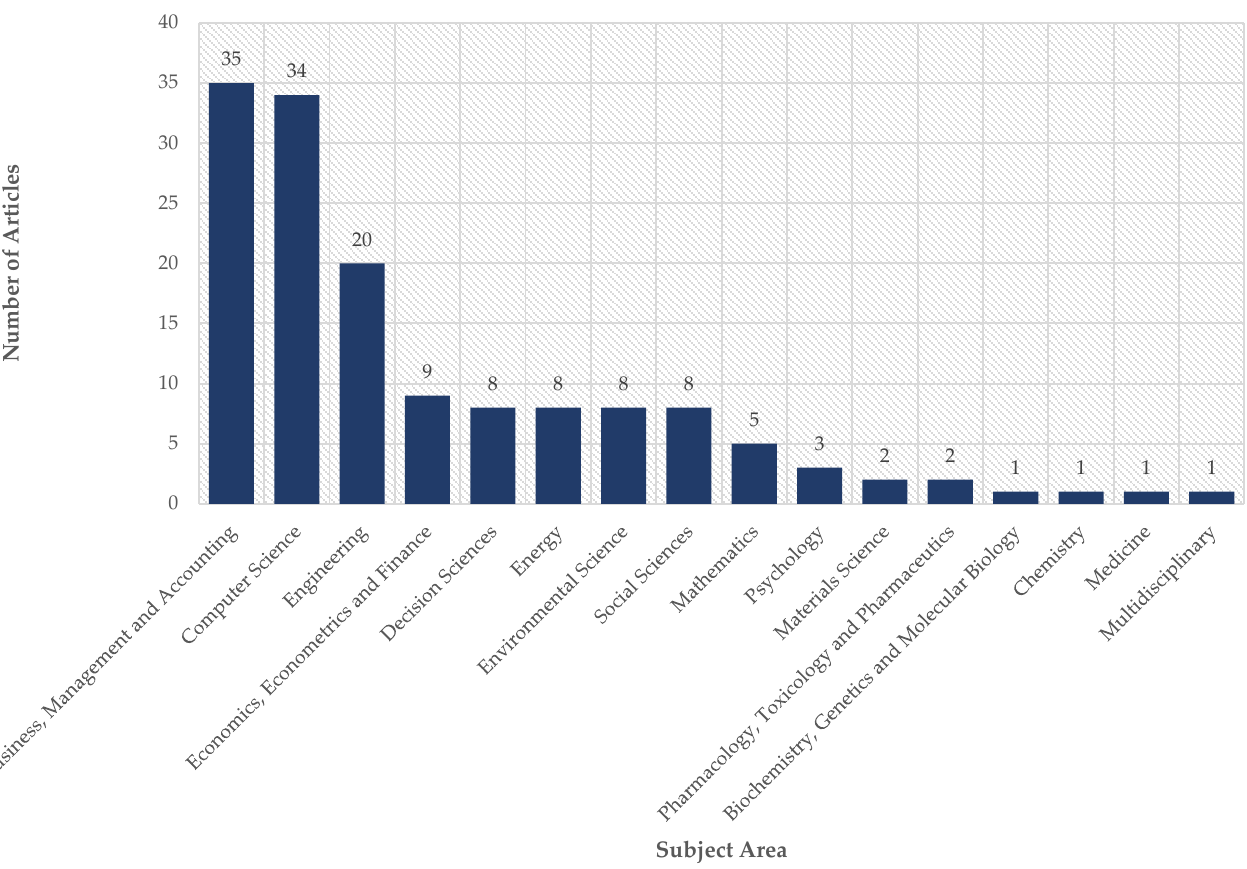
Figure 2. The number of papers published between 2012 and 2022 on the subject. Figure 3 depicts the number of articles published each year between 2012 and 2022.